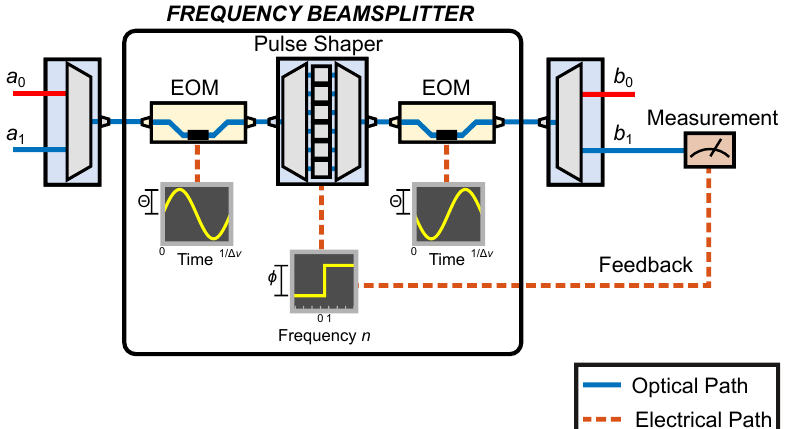
Figure 2. Experimental setup showing a memristor based on the frequency beam